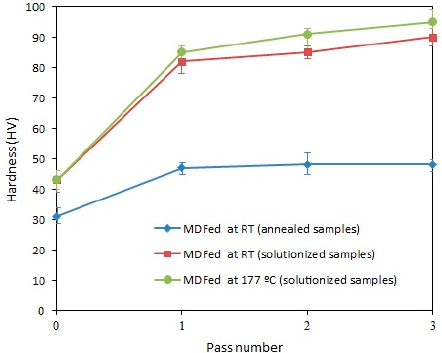
Figure 7. Hardness variations of the annealed and solution ‐ treated samples of AA ‐ 6063 with respect to the MDF pass number.